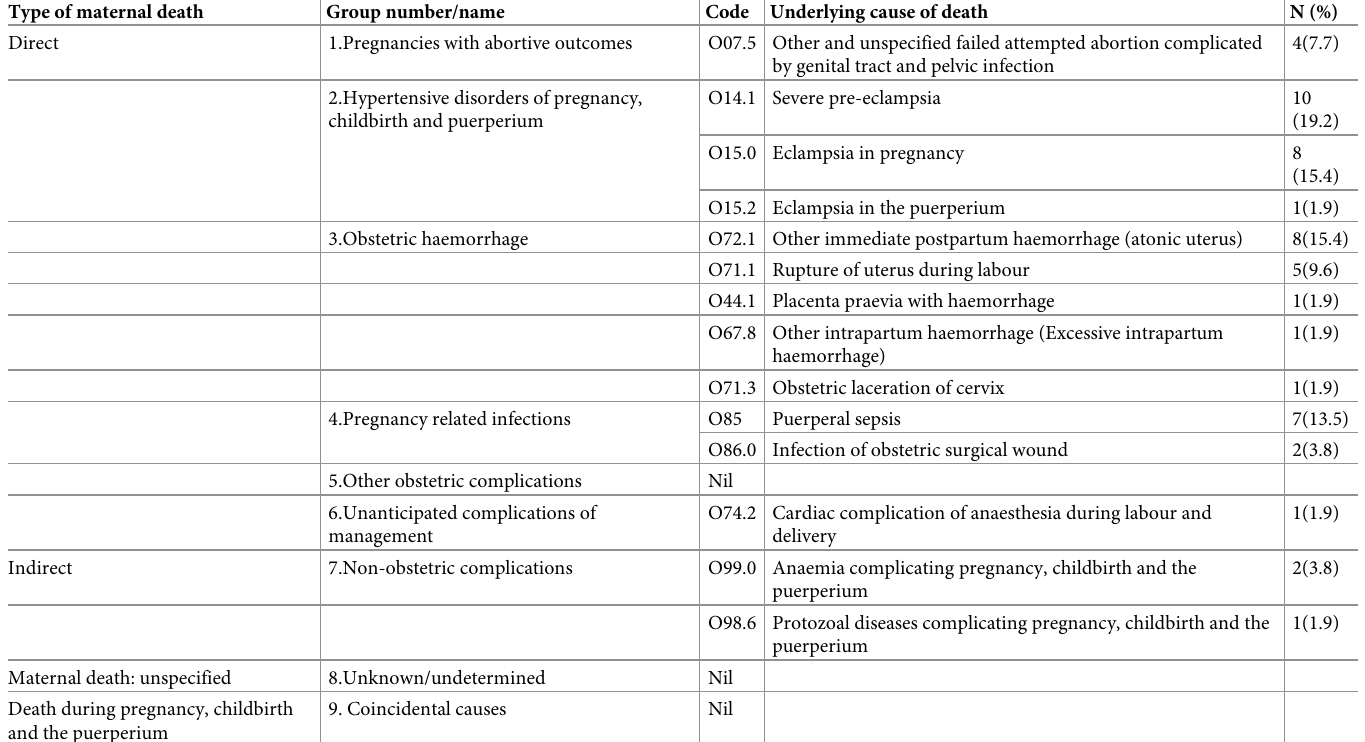
Table 3. Subgroup classification of underlying causes of maternal deaths with WHO ICD-MM codes among cases of maternal death at University of Abuja Teach- ing Hospital, Abuja, Nigeria, 2014–2018 (n =